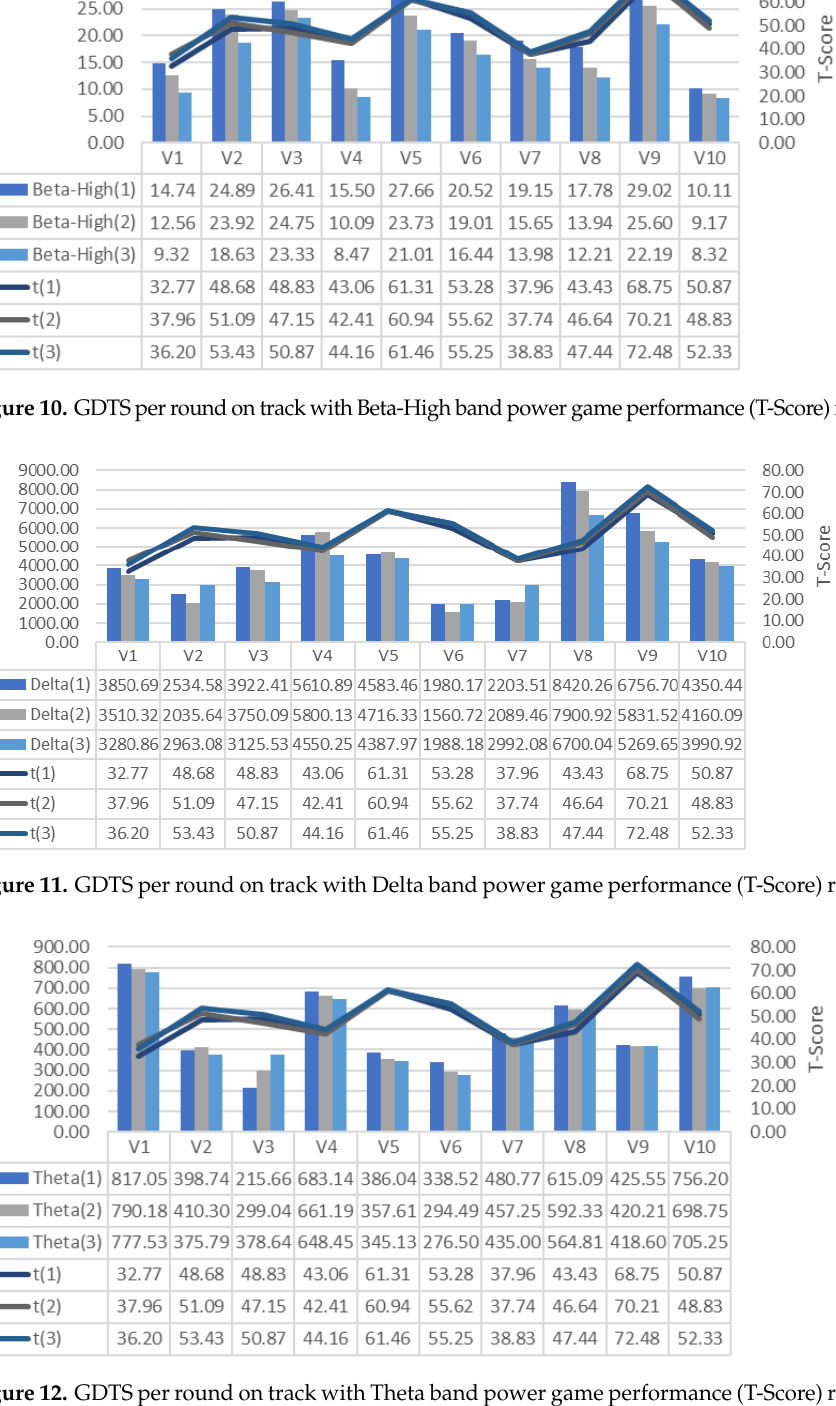
Figure 12. GDTS per round on track with Theta band power game performance (T-Score) relation- ship.